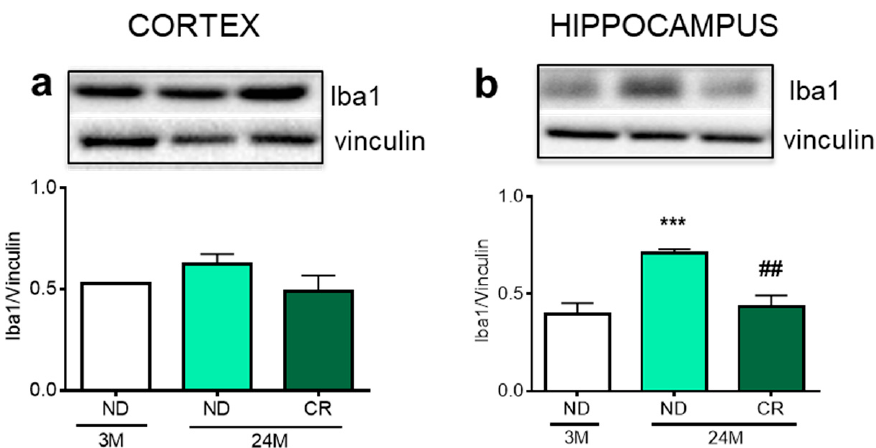
Figure 4. Impact of age and CR on the microglia marker Iba1 in rat cortex and hippocampus. Representative Western blots and densitometric analysis of Iba1 levels in the cortex ( a ) and hippocampus ( b ) normalized to vinculin. 3M (3-month-old rats); 24M (24-month-old rats); ND (normal diet); CR (caloric intake reduced by 40% for the last 6 months of life). Statistical analysis was performed by using one-way ANOVA followed by Tukey’s post hoc test. *** p < 0.001 vs. 3M ND; ## p < 0.01 vs. 24M ND.